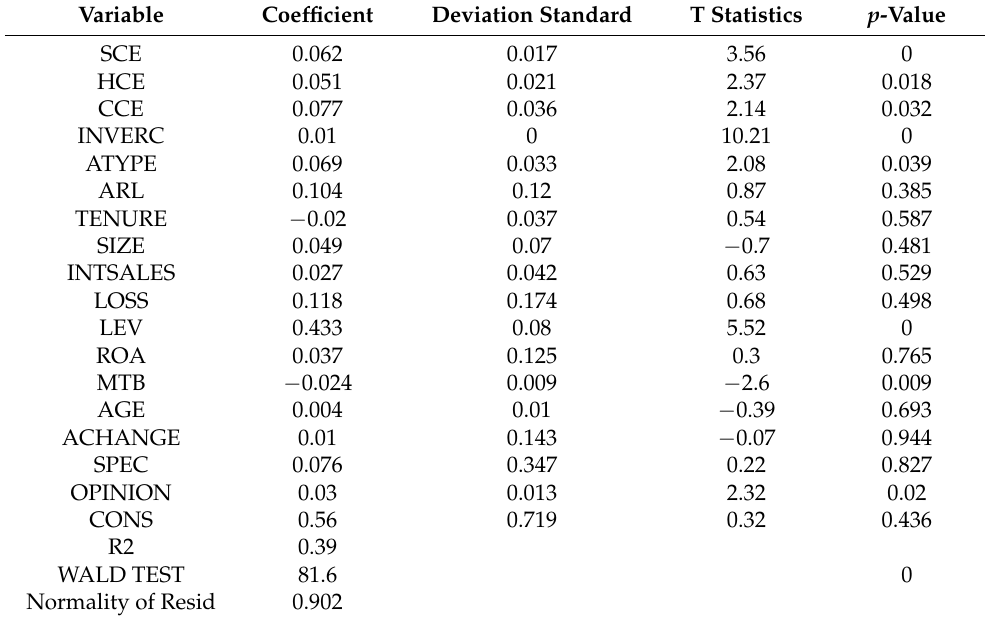
Table 13. The results of estimating the fourth model by the stochastic effects method. Variable